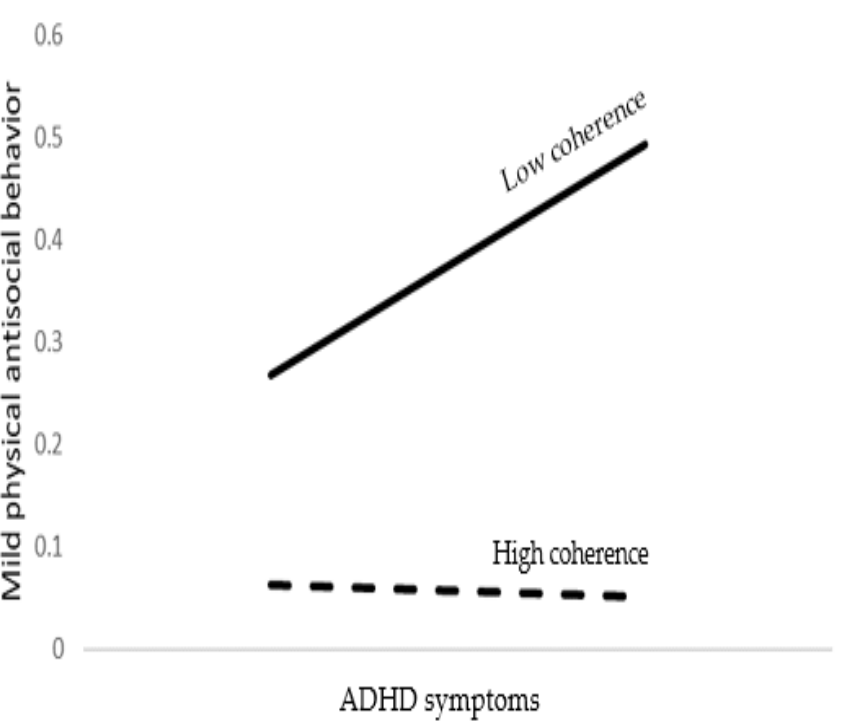
Figure 2. The association between ADHD symptoms and mild physical antisocial behavior as moderated by coherence. Table 5. ADHD symptoms as a predictor of verbal antisocial behavior moderated by coherence.